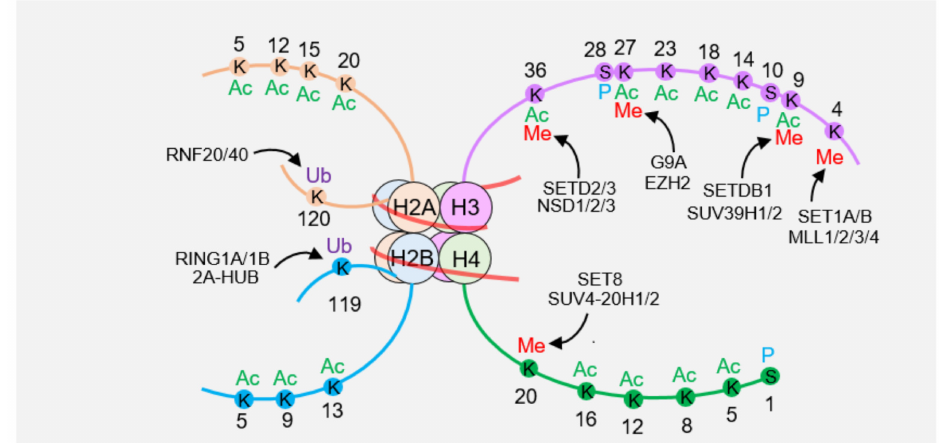
Figure 1. Schematic diagram of histone modification landscape. The nucleosome consists of one H3-H4 tetramer, two H2A-H2B dimers, and the surrounding DNA. There are many modifications on the histone tail, including histone methylation (Me), acetylation (Ac), ubiquitination (Ub), and phosphorylation